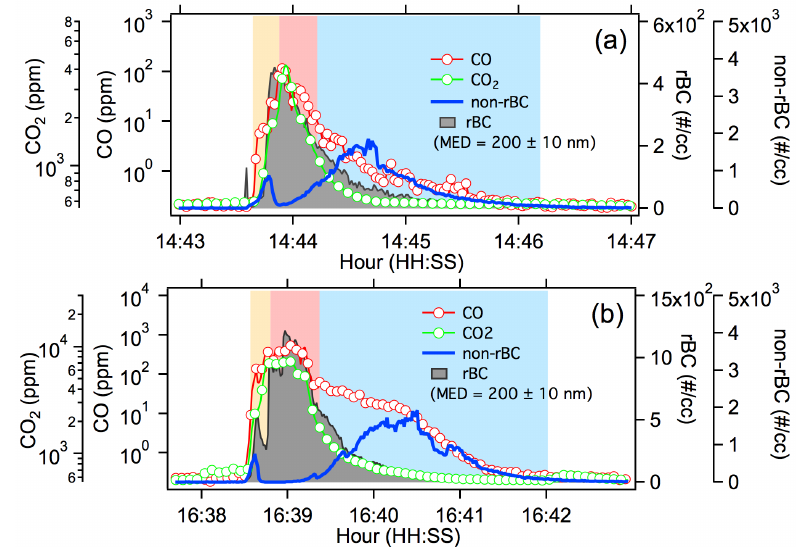
Figure 1. Temporal variations in the mixing ratios of CO and CO 2 , and the number concentrations of rBC and non-rBC particles for the burning of wheat straw (a) and rapeseed plants (b) . The yellow (dry distillation step of the biomass), red (flaming-dominant combustion) and blue (smoldering-dominant combustion) shaded areas in the plot represent the different burning states.